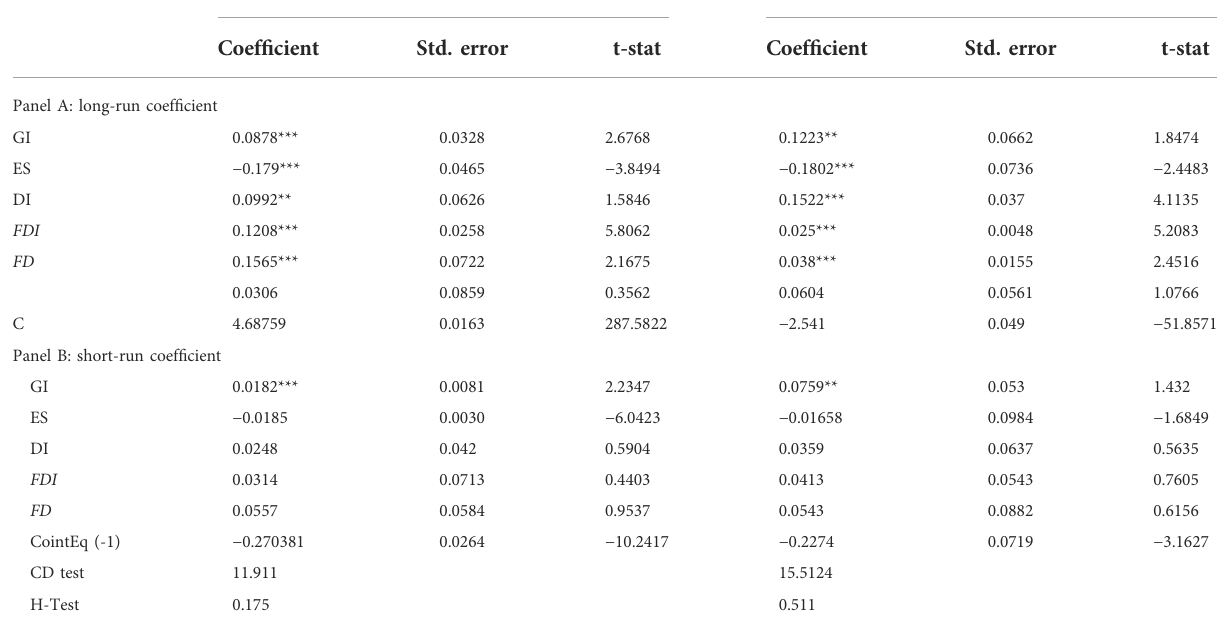
TABLE 6 Results of ARDL and